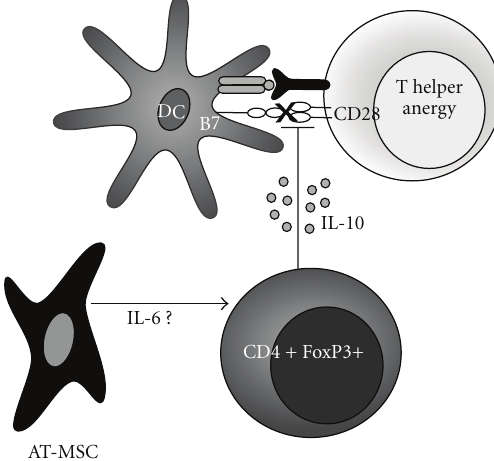
Figure 4: A possible indirect mechanism of the immunoregulatory e ff ects of factors secreted by